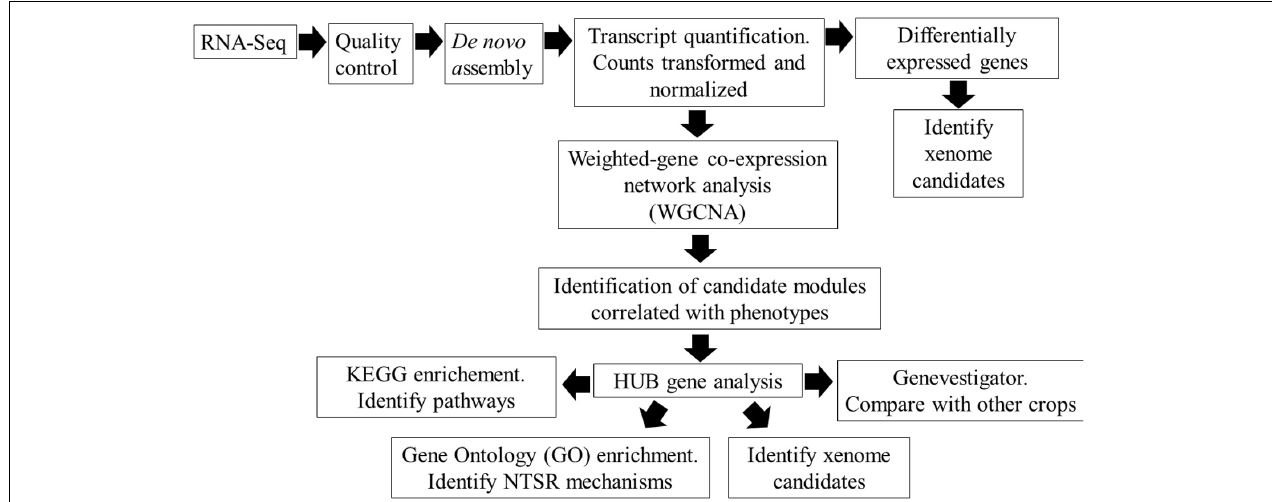
FIGURE 1 | Overview of the workflow for identifying the non-target site resistance (NTSR) mechanisms in black-grass populations using RNA-Seq analysis.